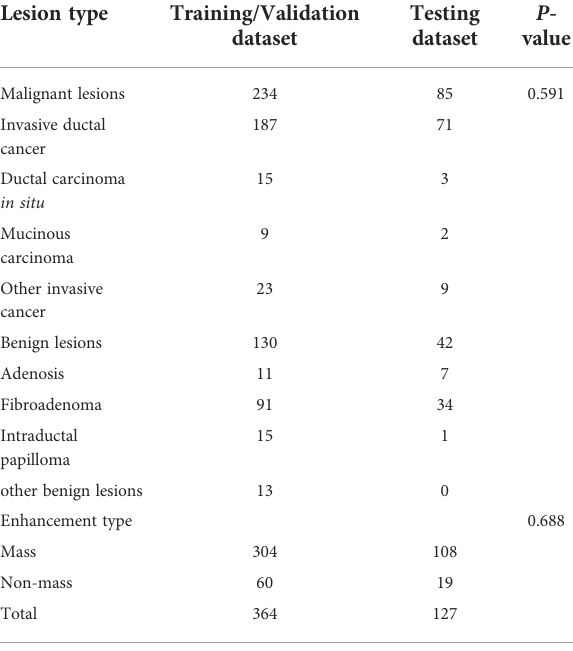
TABLE 2 Pathology Type and Enhancement Type of Lesions Included in the DataSet.